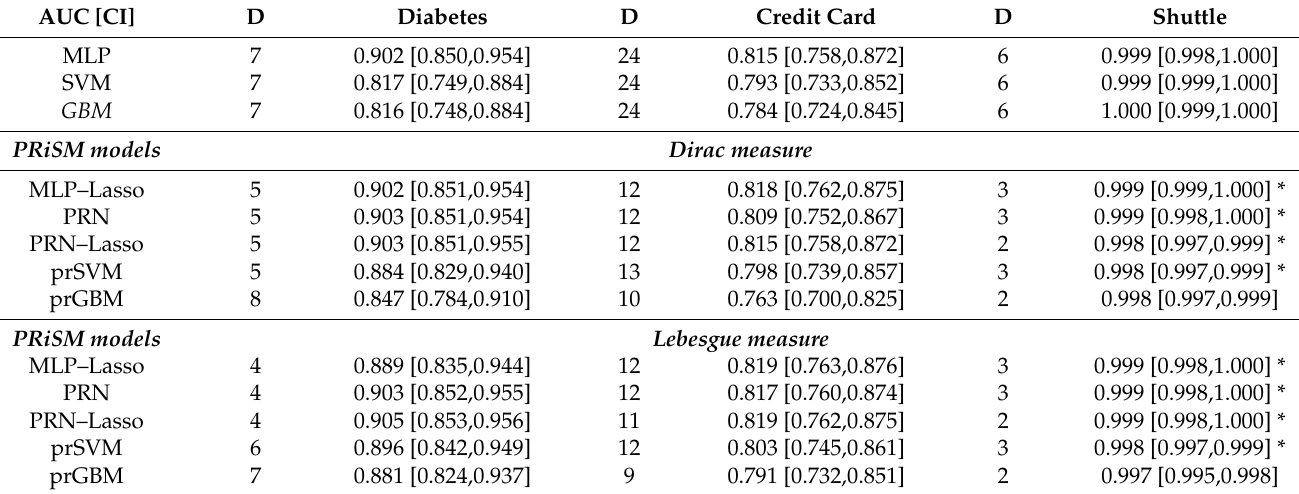
Table 5. Classification performance for the real-valued data sets. The label ‘D’ indicates the number of input variables for the black boxes and component functions for the PriSM